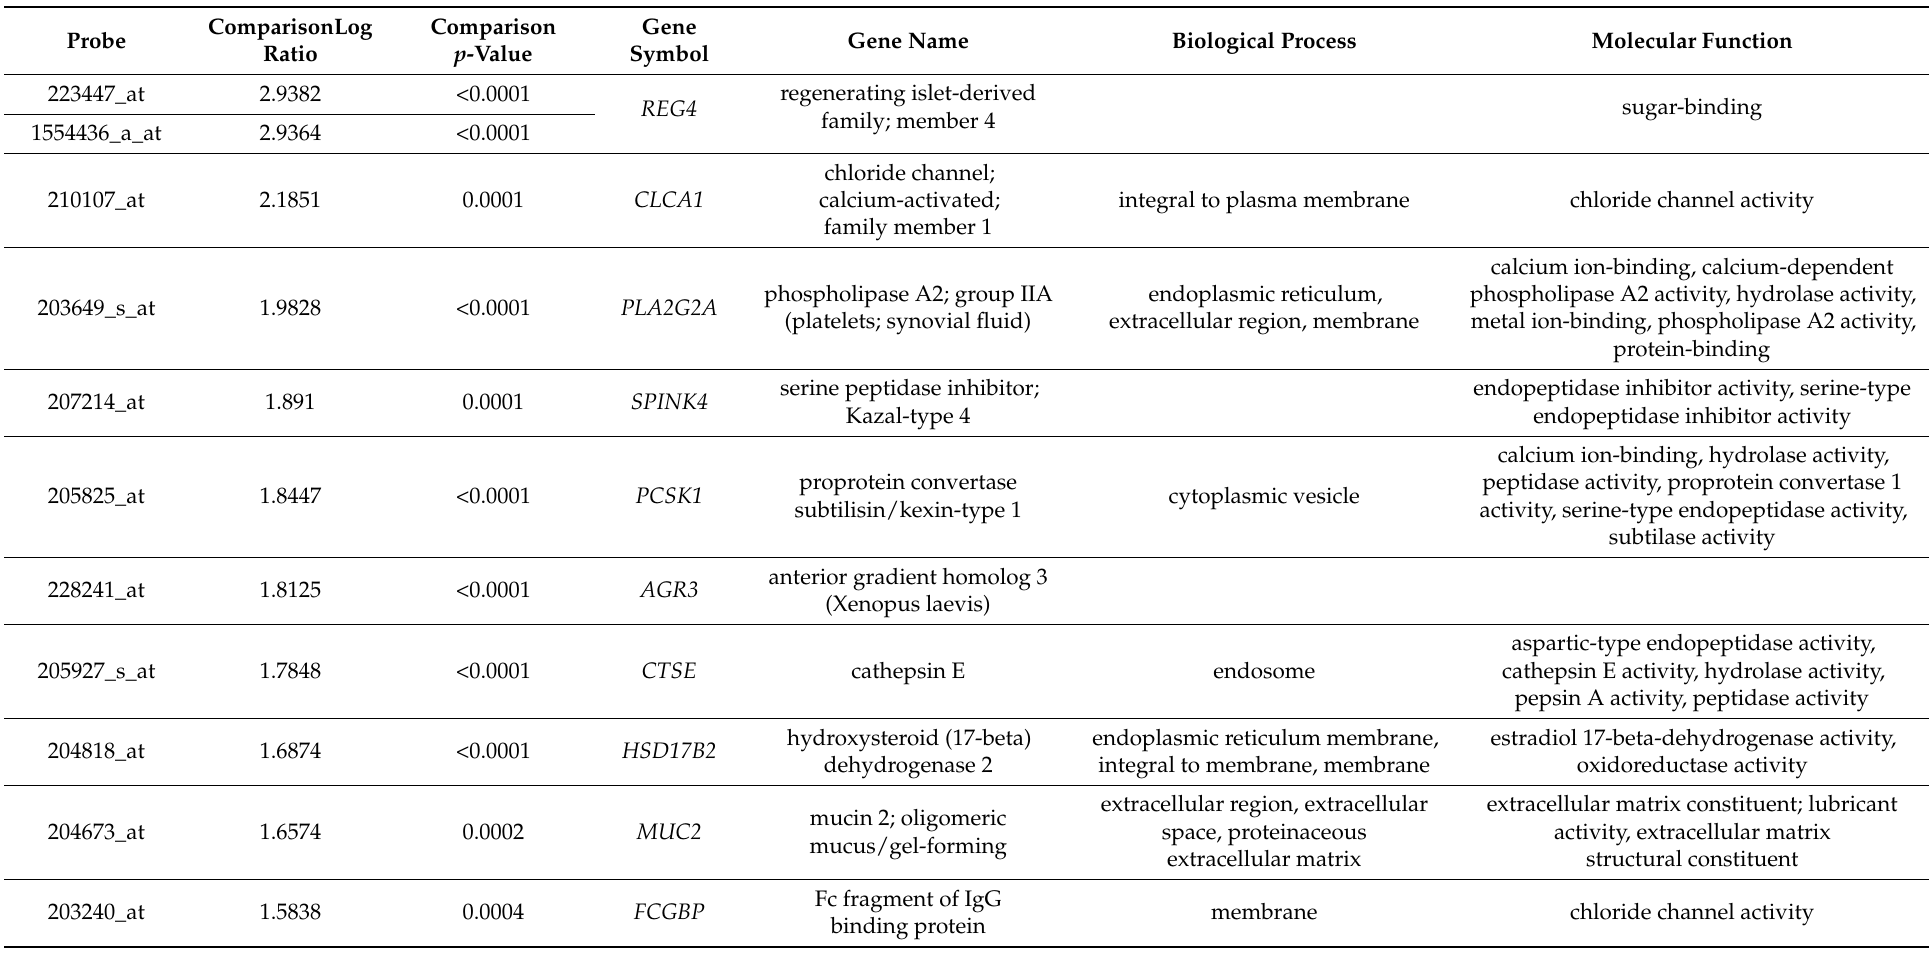
Table 1. Summary of the top 10 differentially expressed genes associated with CCRT resistance in rectal